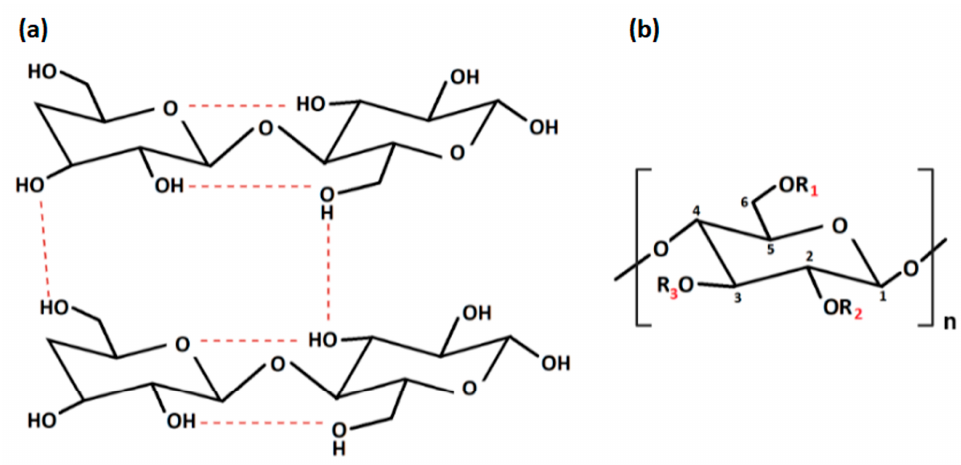
Figure 2. ( a ) Intra- and inter-molecular hydrogen bonds in cellulose; ( b ) repeating unit of cellulose derivatives. “Created with